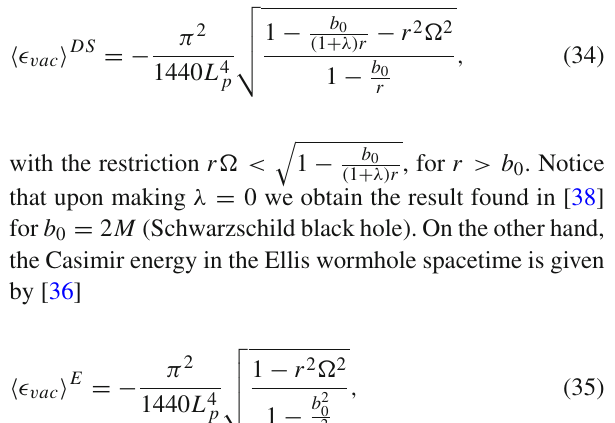
black hole (in this latter, λ = 0 , b 0 = 2 M ), as a function of the radial coordinate, r > b r . b At the right panel the same ratio is shown for a higher value of the rotational parameter, a